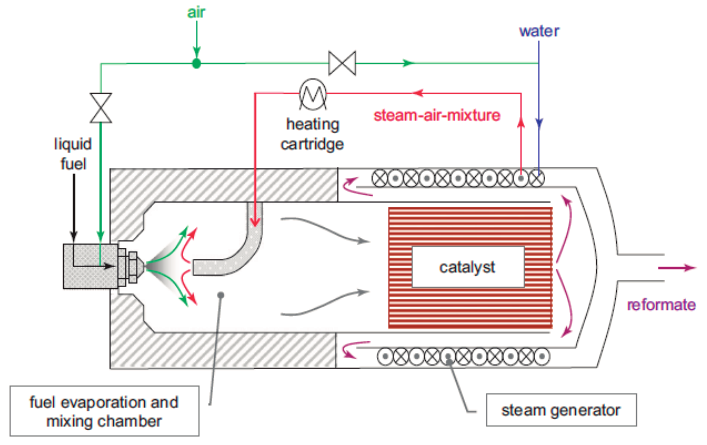
Figure 16. Schematic of ATR 5 [32].